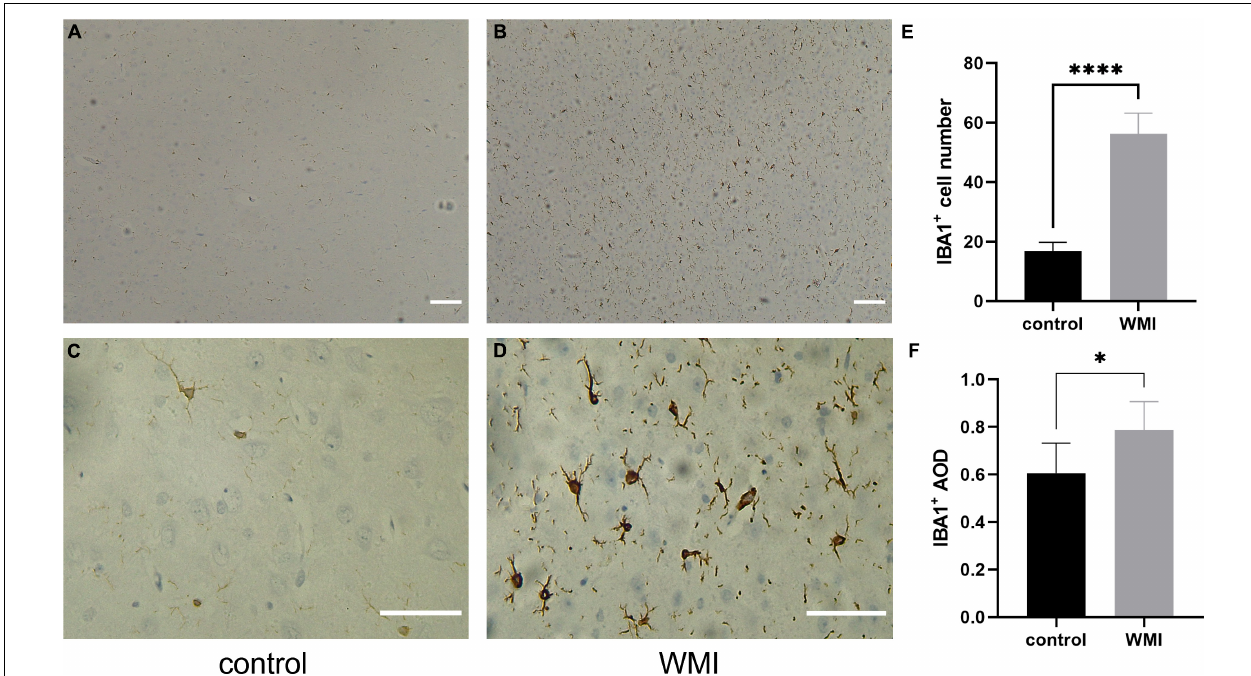
FIGURE 6 | Microglial activation in WMI group. (A,B) The control group is on the left and the WMI group is on the right. Scale bar: 200 µ m. (C,D) A magnified version of A and B. IBA1 + microglia were morphologically diverse, with most cells extending processes. Scale bar: 100 µ m. (E,F) Quantitative analysis of the IBA1-positive areas in each group (2–3 sections were evaluated per pup). Five regions of each specimen were randomly collected to calculate the average number of positive cells and the average optical density. Data are presented as the mean ± SE. Compared to the control group by t -test, ∗ P < 0.05, ∗∗∗∗ P <